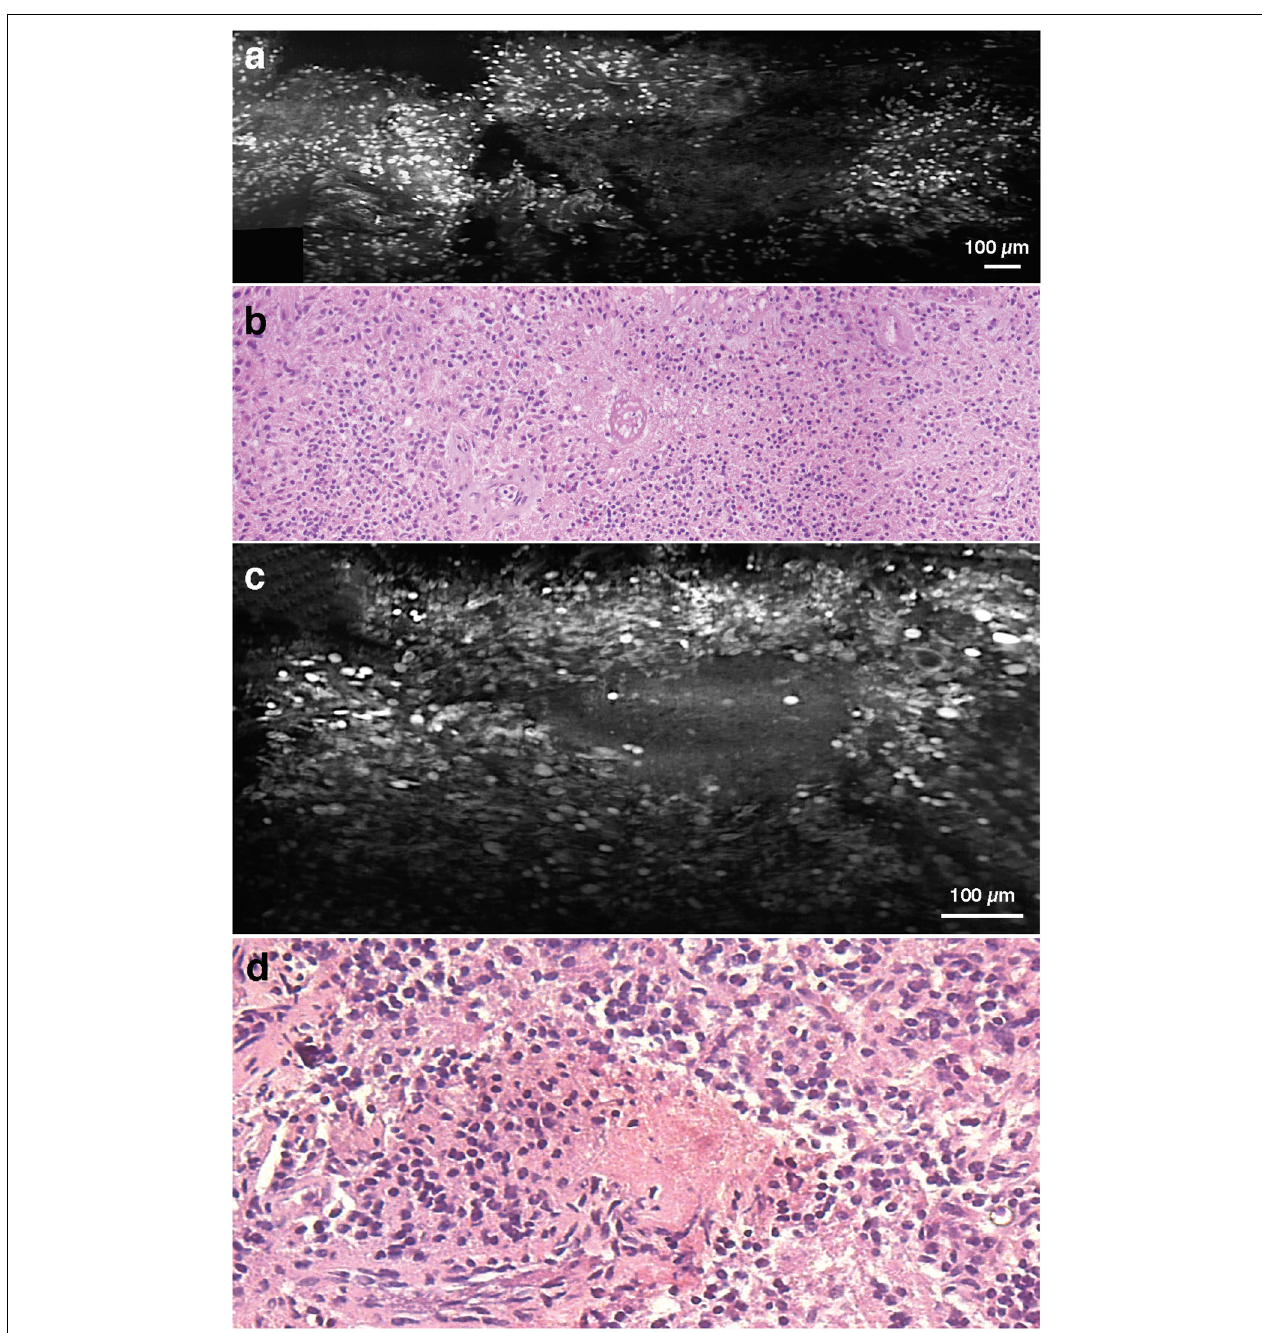
FIGURE 3 | Necrosis. (a) LS-DAC image showing necrotic regions in human gliomas (topically stained with acridine orange), along with (b) corresponding H&E histology. (c) Additional LS-DAC image of necrotic regions in human gliomas stained with acridine orange with (d) corresponding H&E histology. LS-DAC, line-scanned dual-axis confocal; H&E, hematoxylin and